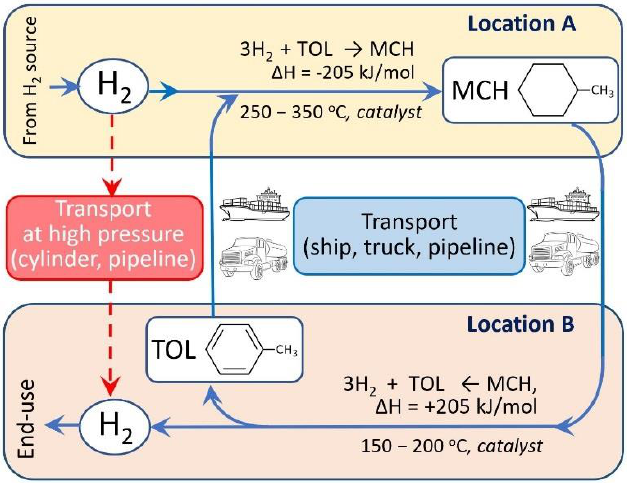
Figure 1. Schematic diagram of MCH-TOL based hydrogen supply chain that can utilize existing transportation infrastructures developed for gasoline, providing a much safer supply compared to the direct supply of high-pressure gaseous hydrogen.